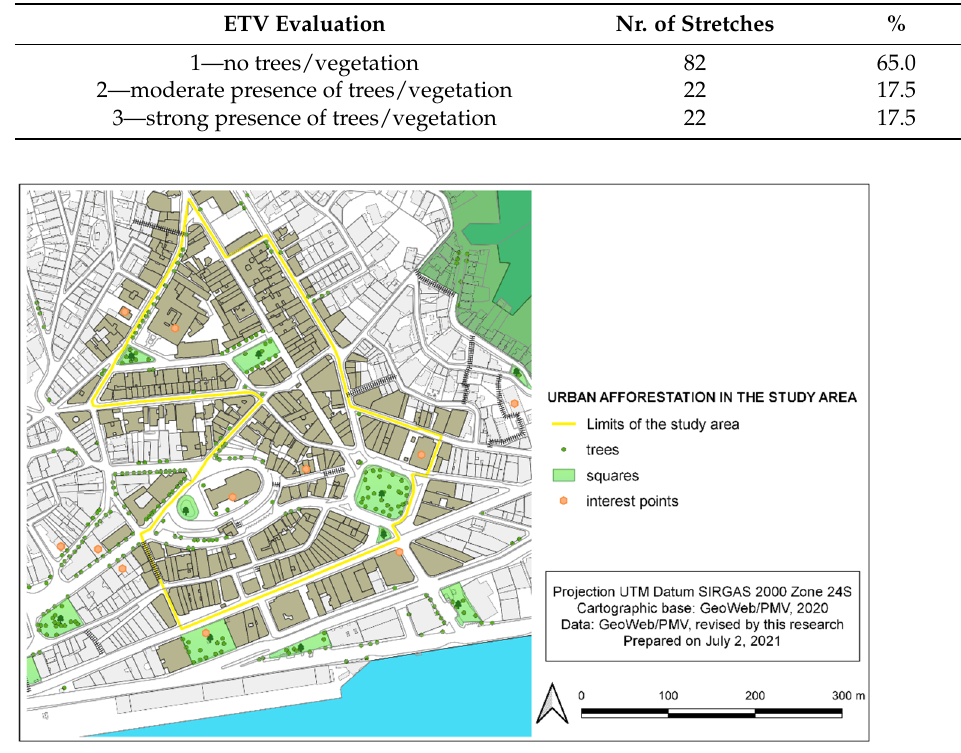
Figure 6. Urban afforestation in the study area, within the historic center of Vitória-ES, Brazil. Source: created by the authors in July 2021, based on data and cartography from GeoWeb/PMV [54].